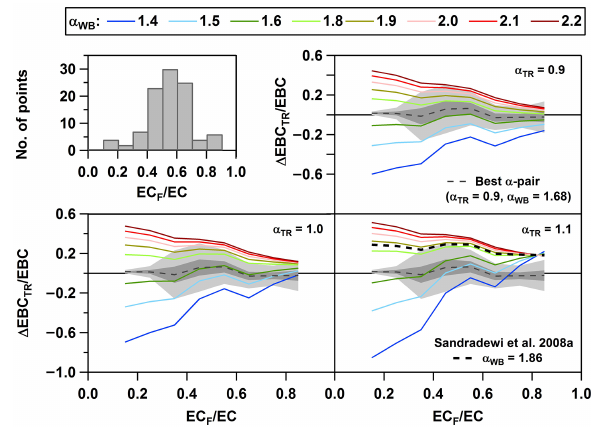
Figure 5. Residuals of EBC TR / EBC compared to EC F / EC ( (cid:49) EBC TR / EBC) as a function of EC F / EC for different com- binations of α TR and α WB . Average (cid:49) EBC TR / EBC values for EC F / EC bins of 0.1 are calculated for α WB = 1.4–2.2 and α TR = 0.9 (upper right panel), α TR = 1.0 (lower left panel) and α TR = 1.1 (lower right panel). (cid:49) EBC TR / EBC for α TR = 0.8 can be found in Fig. S2. The number of points per EC F / EC bin is dis- played in the upper left panel. The dashed grey line denotes the best α pair ( α TR = 0.9 and α WB = 1.68) as obtained in Sect. 3.2.1 and the dark and light grey shaded areas mark the 1 σ (standard devia- tion) and 3 σ of (cid:49) EBC TR / EBC per EC F / EC bin for this best α pair. The black dashed line in the lower right panel represents the α combination obtained by Sandradewi et al. (2008a) who first used the Aethalometer